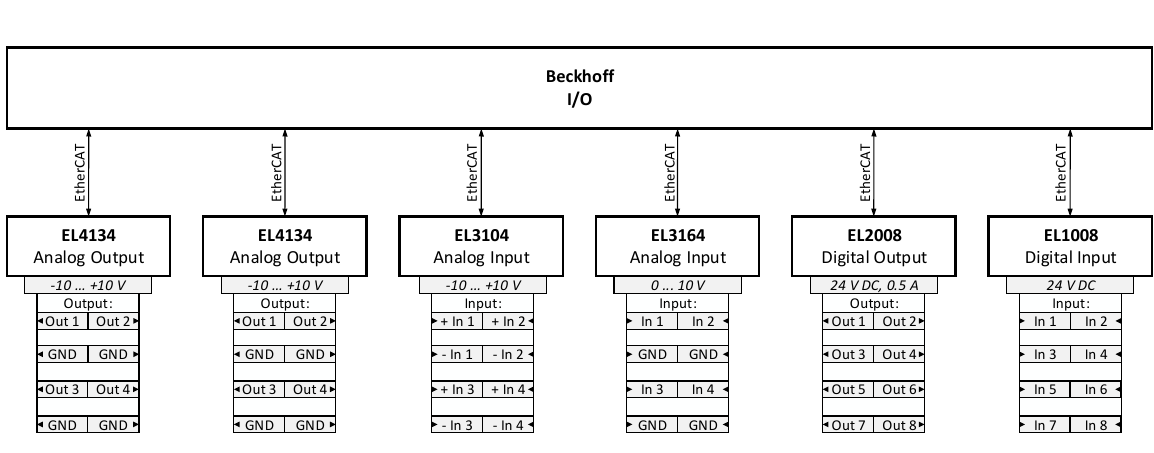
Figure 8: Overview of the available Analog and Digital I/O Modules of the Beckhoff CX 2040 control unit.